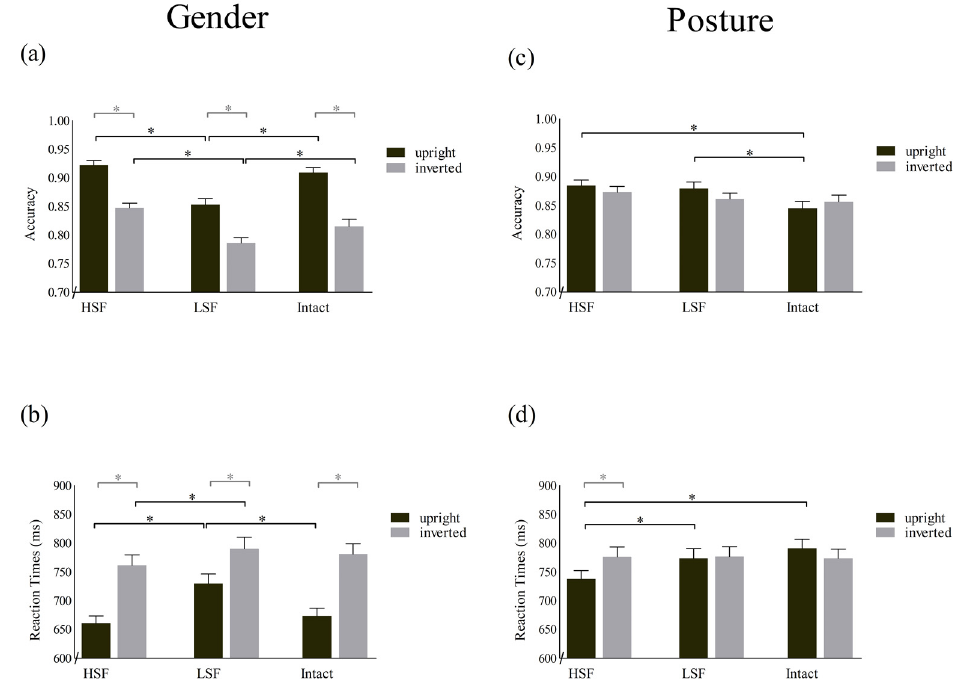
Figure 3. Participants’ performance in the matching-to-sample task under the different spatial frequency conditions (i.e., intact, LSF, and HSF) of upright and inverted bodies. Means and standard errors of the mean for “Accuracy” and “Reaction Times” (RTs) in the Gender task are reported in panels ( a ) and ( b ), respectively. Means and the standard error of the mean for “Accuracy” and RTs in the Posture task are reported in panels ( c ) and ( d ), respectively. Asterisks indicate a significant comparison ( p < 0.05) between the SF condition (black brackets) and orientation (grey brackets).